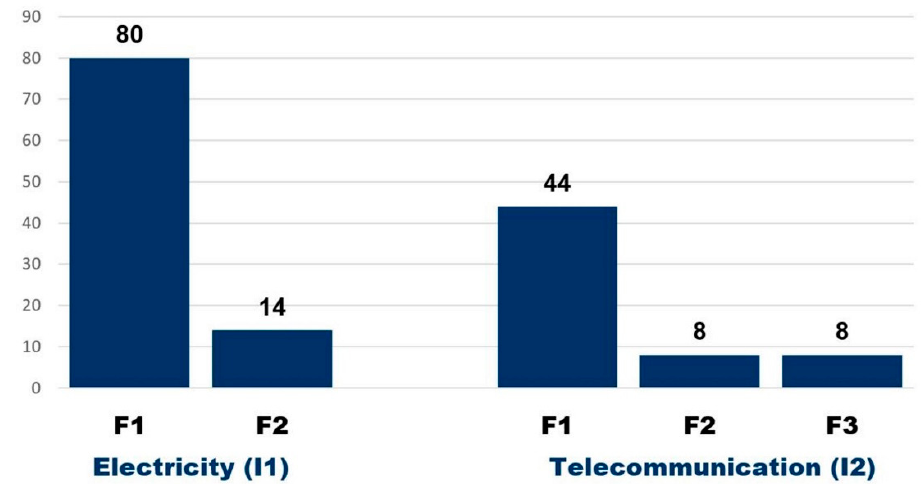
Figure 2. Distribution of the faults present in each of the facilities.